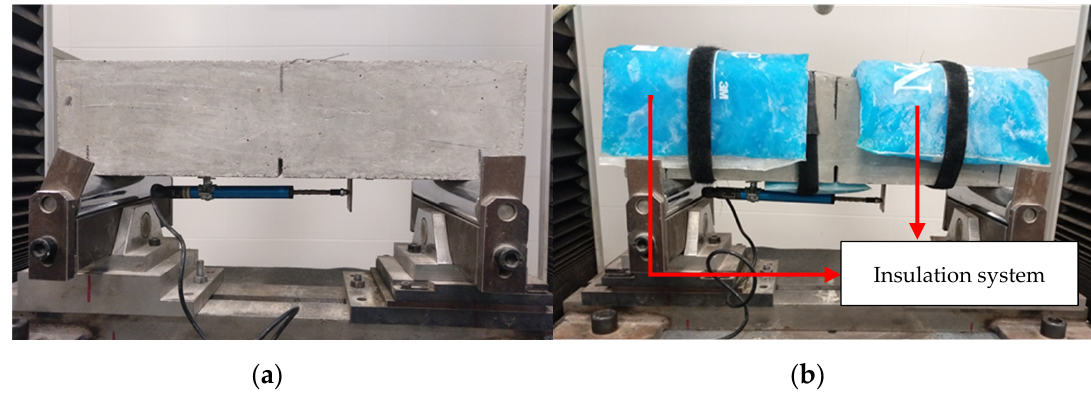
Figure 5. Experimental set-ups used for testing the beams: ( a ) at standard temperature and ( b ) at target temperature with the designed system.